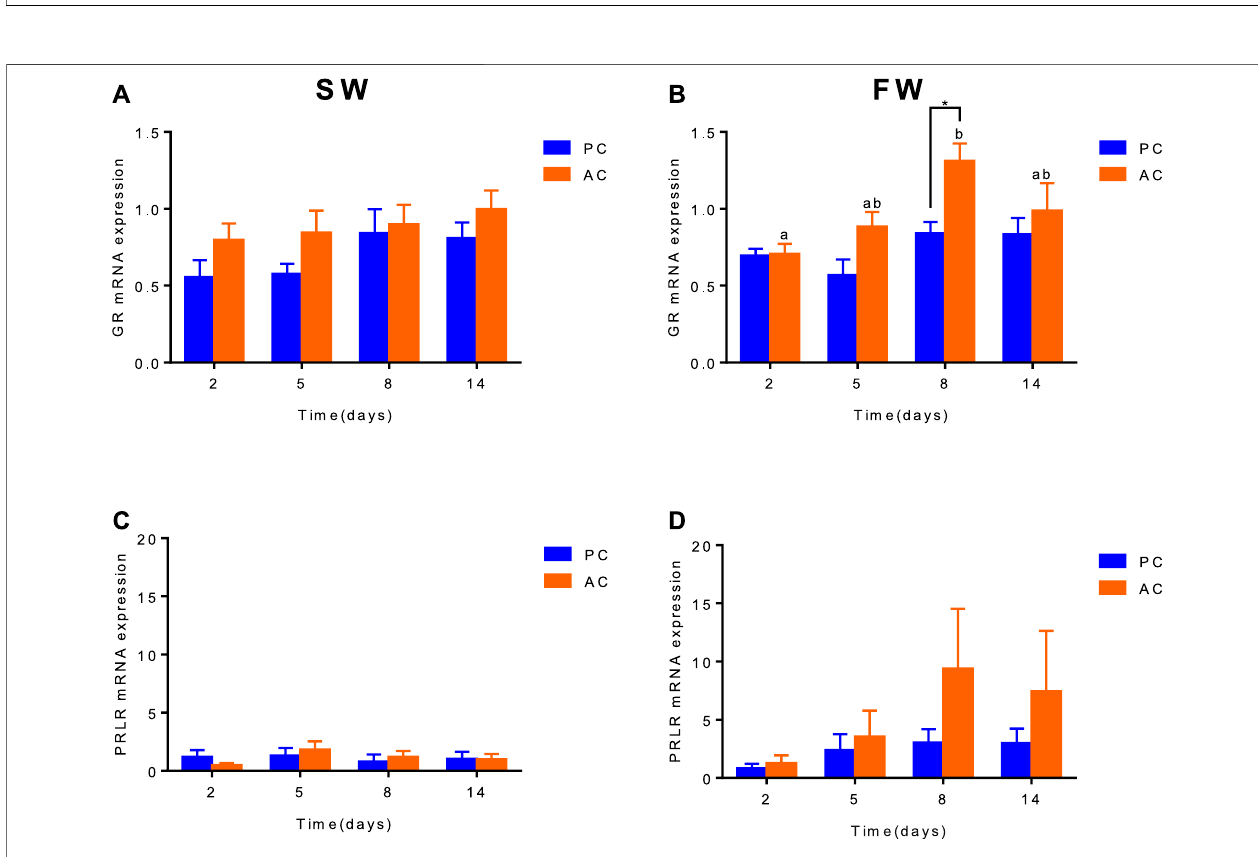
FIGURE 2 | The branchial gene expression of GR (A,B) and PRLR (C,D) in olive fl ounder with passive coping style (PC) and active coping style (AC) either in seawater(SW, A,C ),oraftertransfertofreshwater(FW, C,D ).Dataaremean±SEM( n =6).Anasterisksigni fi esasigni fi cantdifferencebetweenthePCandACgroupsat each time point ( p < 0.05). Different letters denote a signi fi cant difference across time within the same coping style group ( p < 0.05).